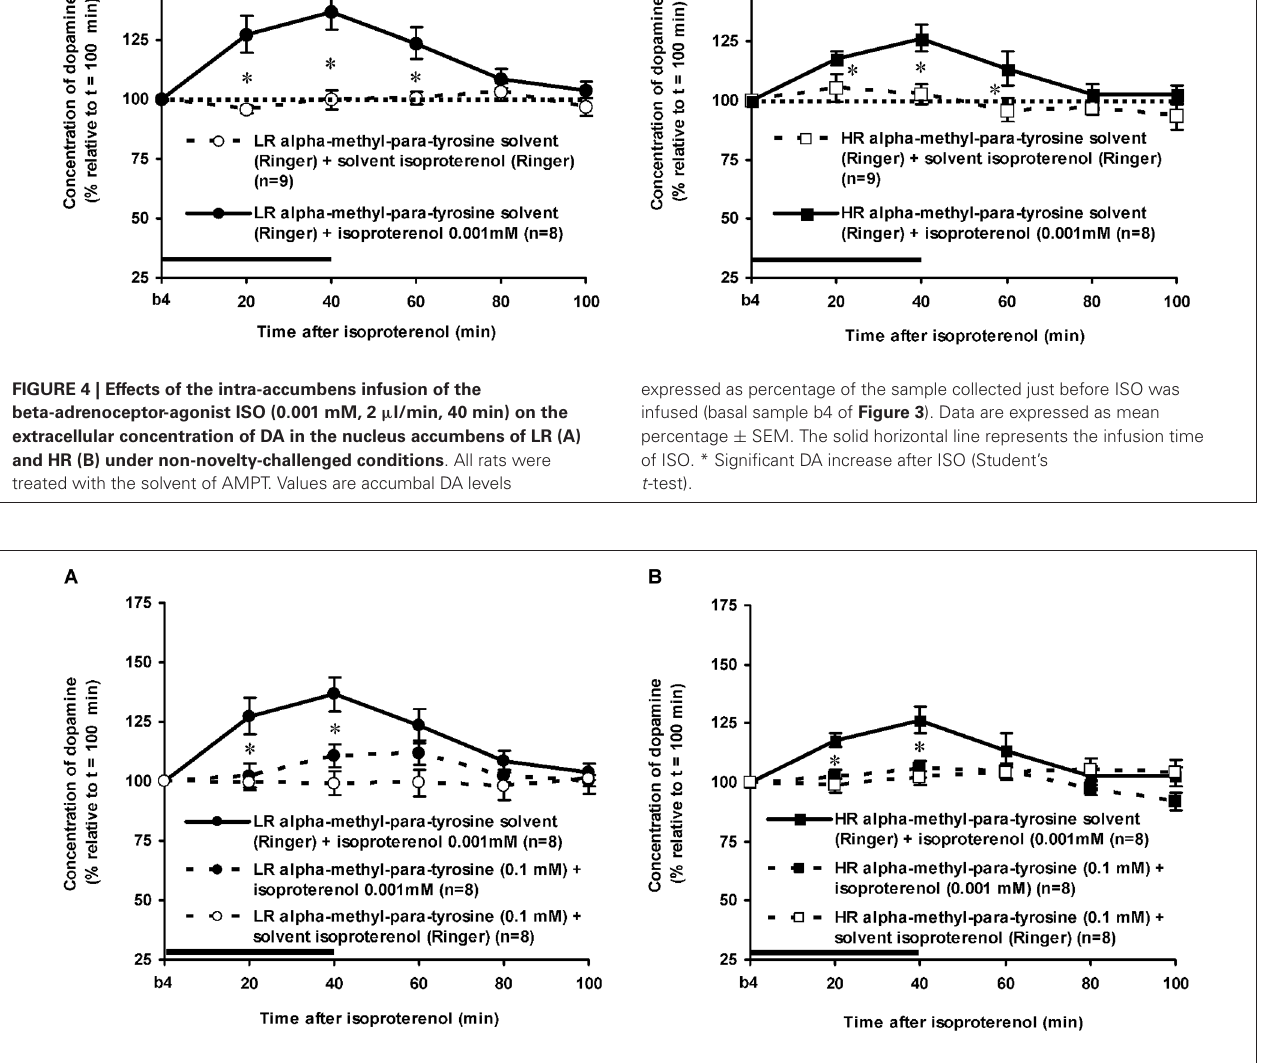
FIGURE 5 | Effects of AMPT (0.1 mM, 2 µ l/min, 40 min) on the ISO-induced increase of the extracellular concentration of DA in the nucleus accumbens of non-challenged LR (A) and non-challenged HR (B) . Values are accumbal DA levels expressed as percentage of the sample